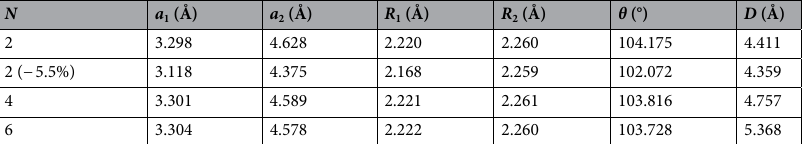
Table 1. The optimized lattice constants ( a 1 and a 2 ), the bond lengths ( R 1 and R 2 ), the angle between the R 1 and R 2 bonds ( θ ), and the distance ( D ) of the layer interval having the mirror symmetry for the multiple layer BP films ( N = 2, 4, 6). The second line gives the results of the bilayer BP with a 5.5% biaxial compressive